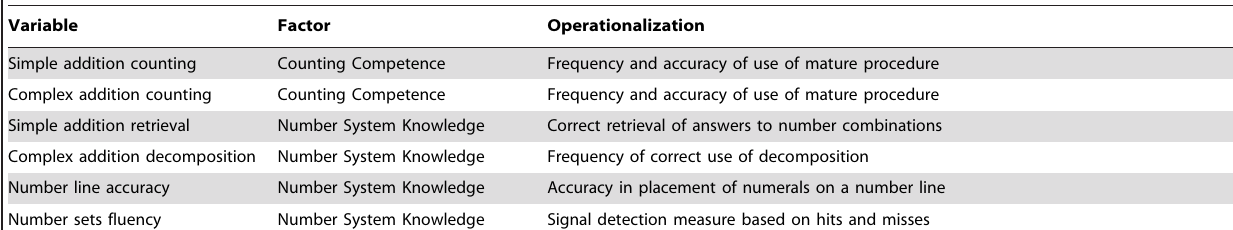
Table 1. School Entry Mathematical Cognition Variables.